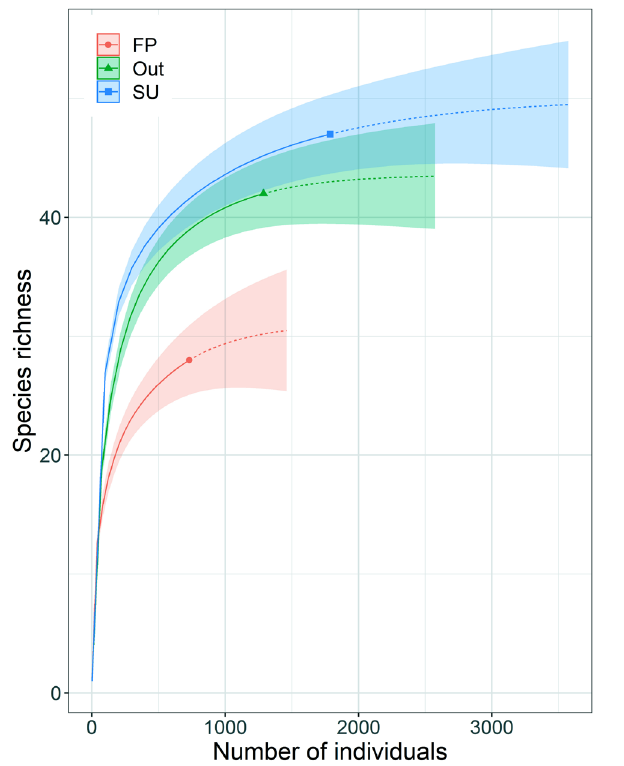
FIGURE 4 | Sample-size-based species richness rarefaction interpolation (solid line) and extrapolation (dotted line) sampling curves of full protection (FP), sustainable use (SU), and outside (Out) with confidence